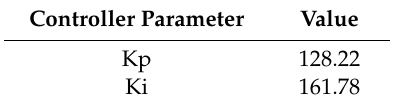
Table 3. Proportional-integral (PI) controller parameters using the proposed approach.